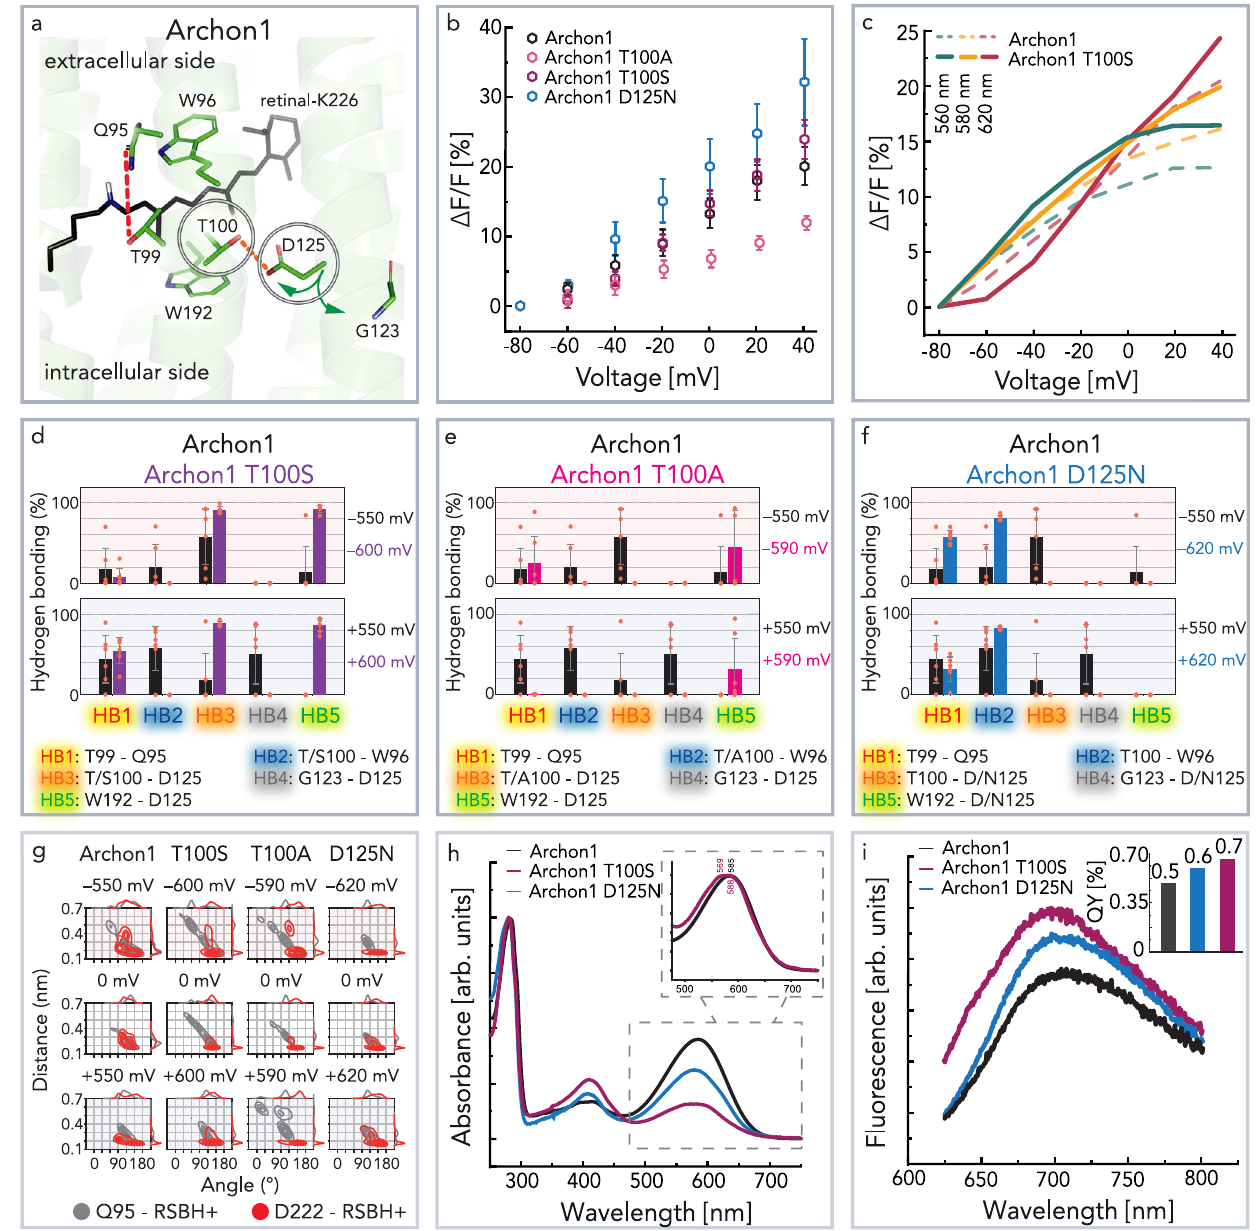
Fig. 4 | Archon1-T100S/A and Archon1-D125N. a Retinal binding pocket high- lighting mutated residues — T100 and D125. b Voltage-dependent increase in